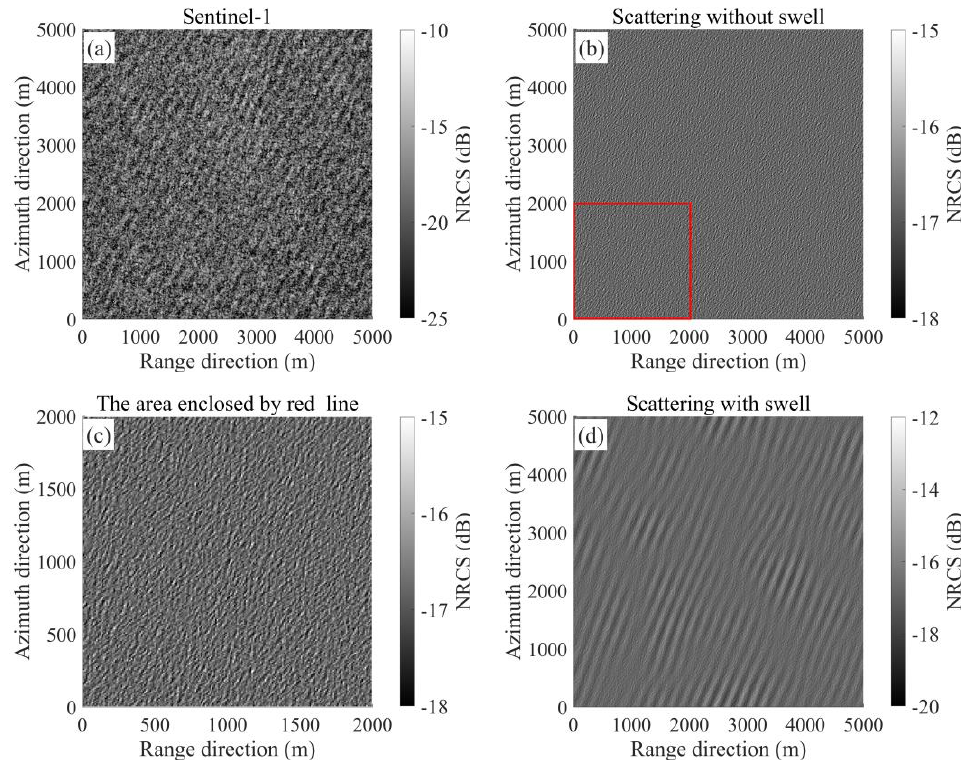
Figure 19. Similar to Figure 17 but corresponding to ID 2. Table 3. The wavelength and direction of dominant wave obtained from the image spectra in Fig- ure 20.